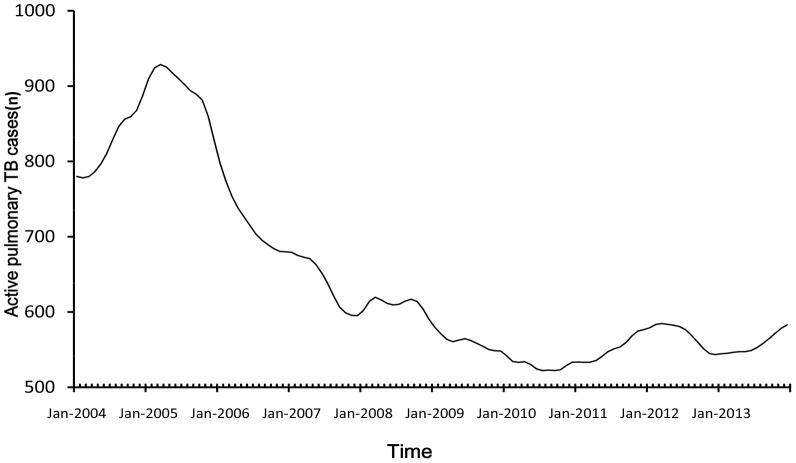
The trend component of time series.